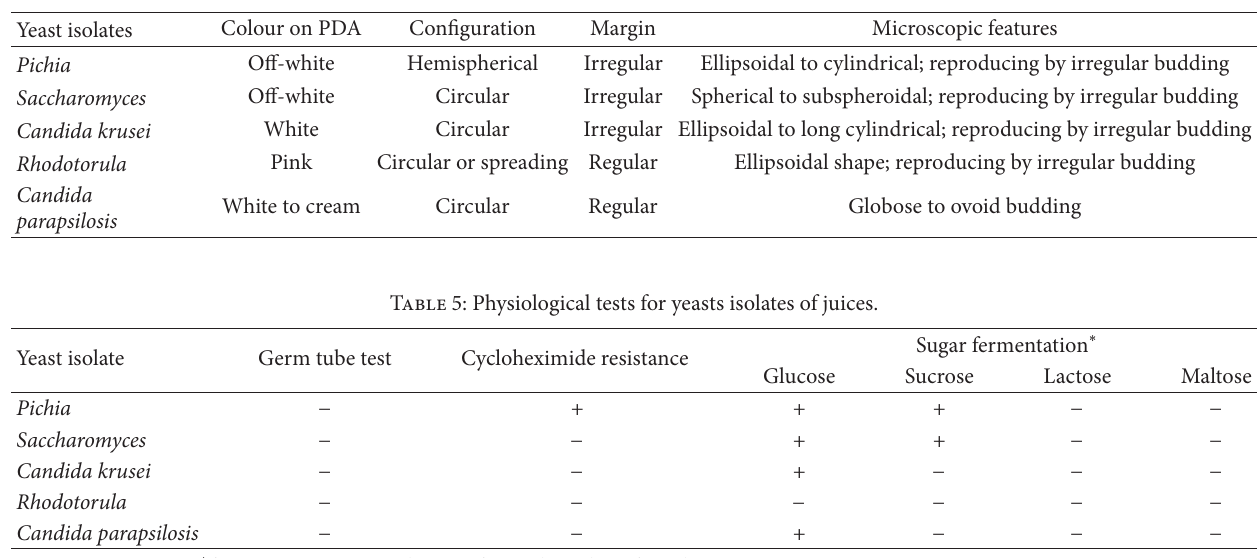
Table 4: Morphological details of yeast isolates of juices.